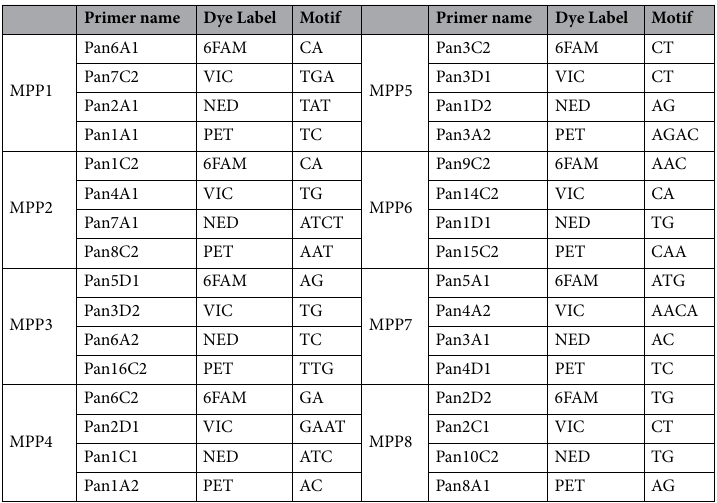
Table 4. Multiplex PCRs (4 microsatellite in each